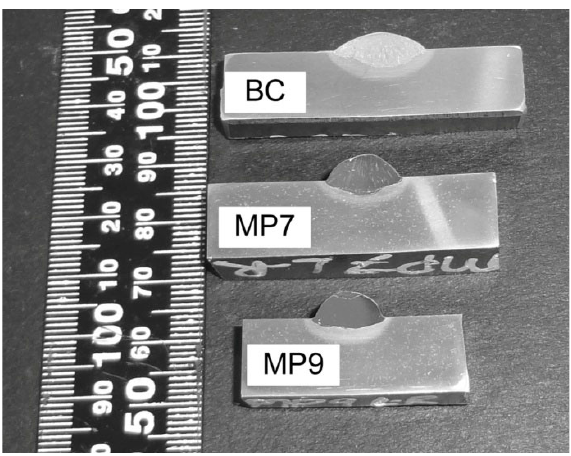
Figure 1. Photograph of BC, MP7 and MP9 weld metal cross ‐ sections.